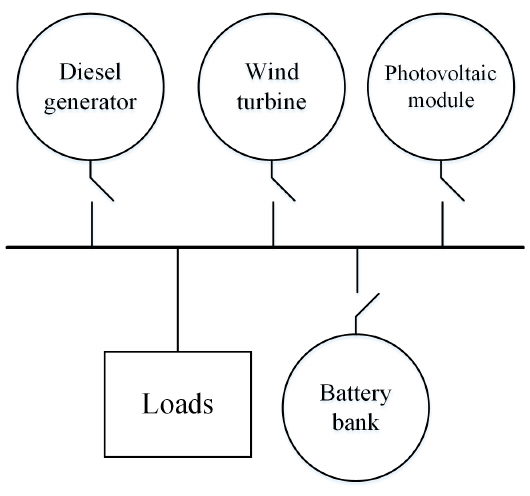
Figure 2. Line diagram of the microgrid topology.